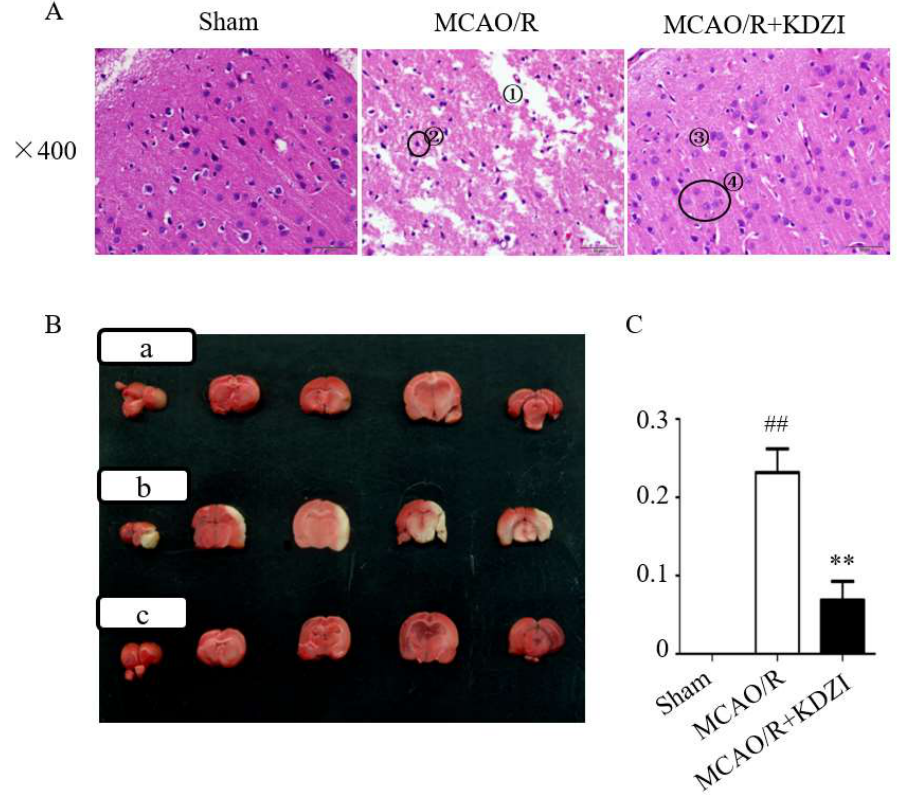
Figure 1. The representative images of HE ( A ) and TTC ( B , C ) stainings of brain sections showing the neuroprotective effect of KDZI on focal cerebral ischemia. The place marked by ① in Figure 1A indicates cytoclasis and ② indicates the karyopyknosis of the cortex of the brains in MCAO/R rats. ③ indicates brain edema was significantly alleviated and ④ indicates the neuronal cells almost returned to normal. Figure 1B shows: ( a ) the sham group; ( b ) MCAO/R group; and ( c ) MCAO/R + KDZI group. Data are presented as mean ± SD. ## p < 0.05 with the sham group, ** p < 0.05 compared with MCAO/R group.